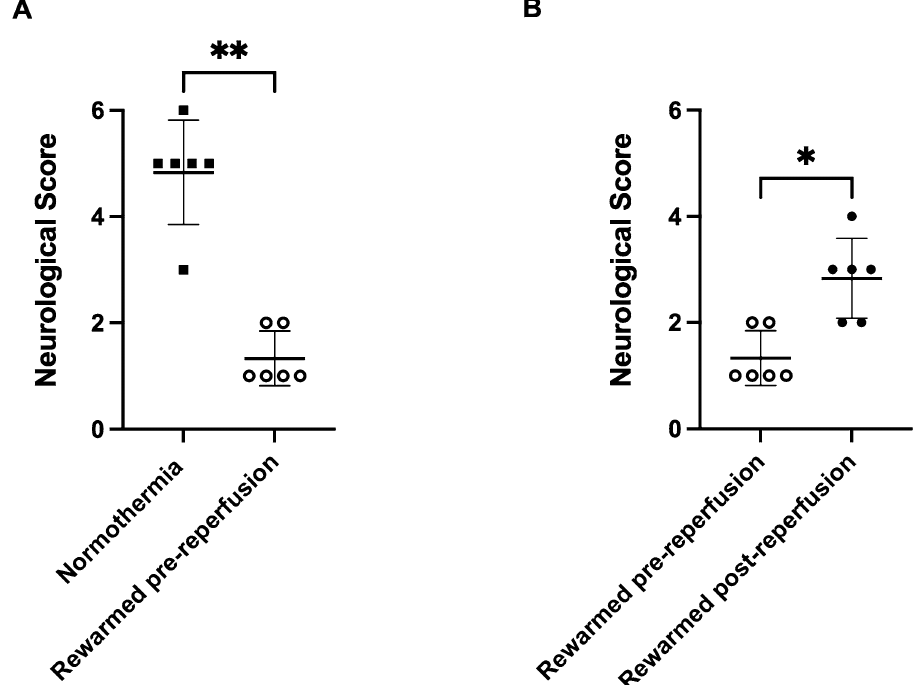
Figure 4. Neurological deficit scores in ( A ) rewarmed pre-reperfusion and normothermia and ( B ) rewarmed pre-reperfusion and rewarmed post-reperfusion animals. * p < 0.05, ** p <